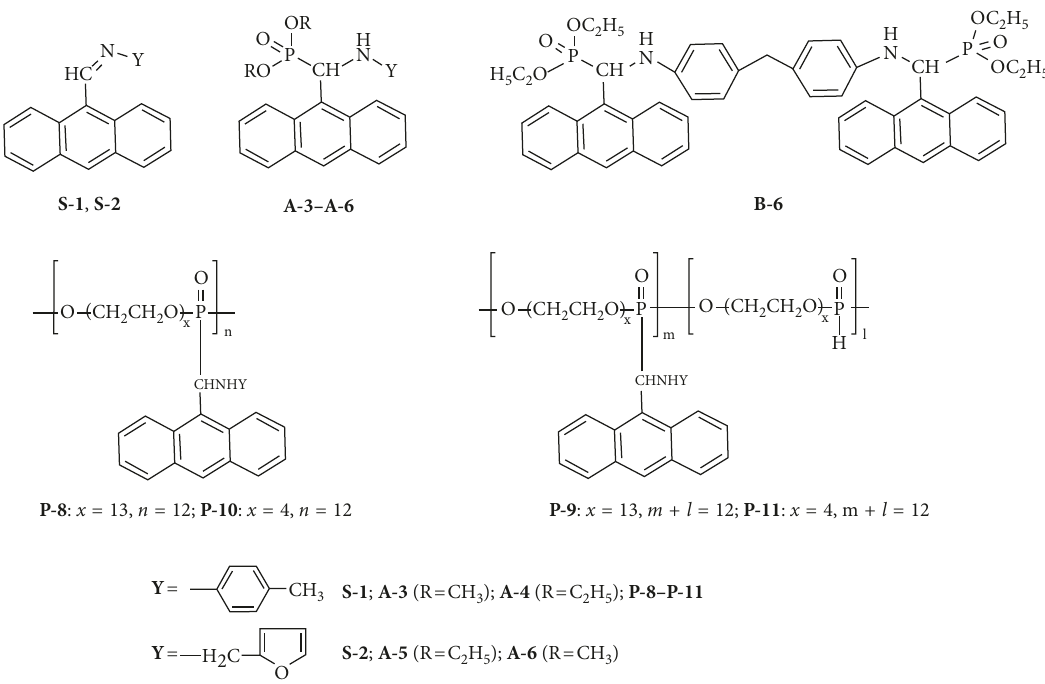
Figure 1: Chemical structure of Schiff bases S-1 and S-2 , α -aminophosphonates A-3 – A-6 , bis-aminophosphonate B-6, and poly- phosphoesters P-8 – P-11 . Table 1: In vitro cytotoxicity (mean IC 50 values, [ µ M] ± SD) of the tested compounds and the referent drug cisplatin against the human leukemic lines HL-60, SKW-3, REH, and K-562.